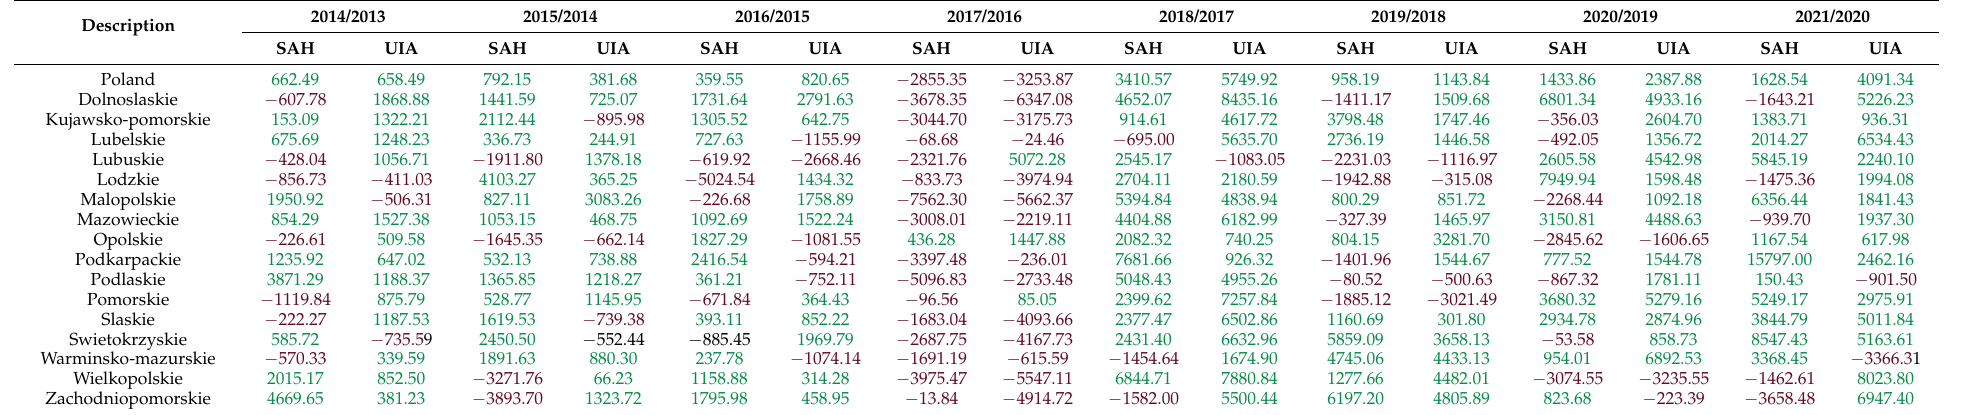
Table 4. The change in levels of reported services per patient by value for provinces from 2013 to 2021 in total and for SAH and UIA